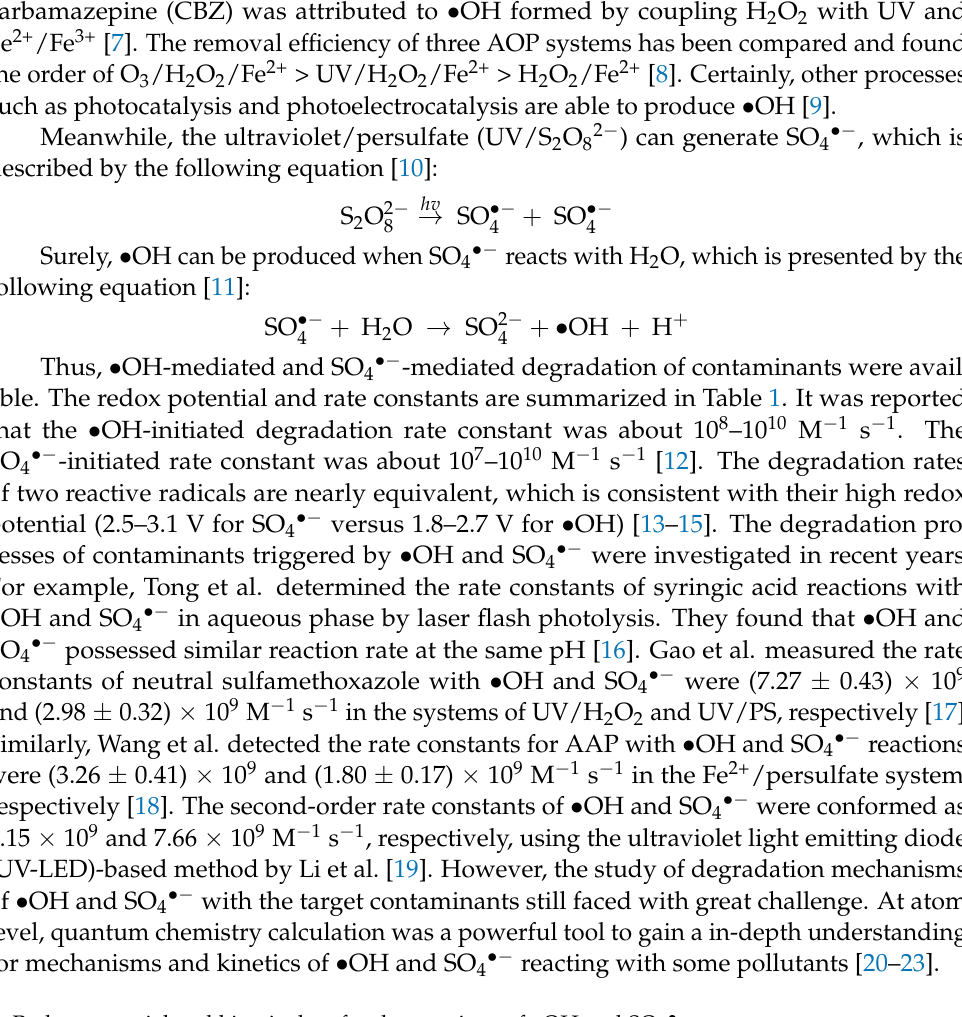
Table 1. Redox potential and kinetic data for the reactions of • OH and SO 4 •−